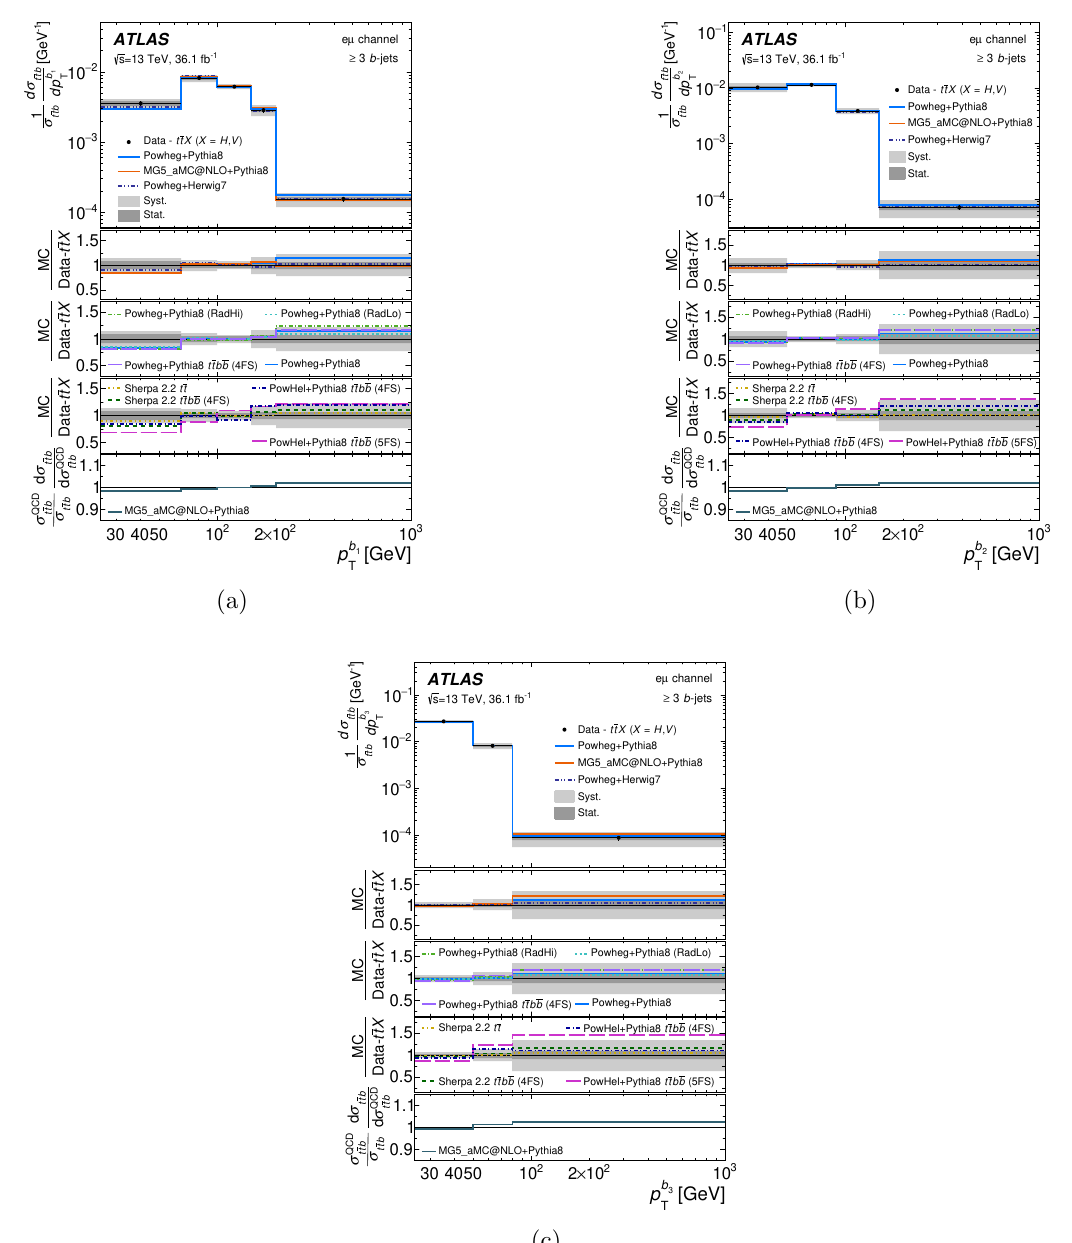
Figure 12. Relative di(cid:11)erential cross-sections as a function of b -jets p T for p T -ordered b -jets in events with at least three b -jets in the e(cid:22) channel compared with various MC generators. The t (cid:22) tH and t (cid:22) tV contributions are subtracted from data. (a) leading b -jet p T , (b) sub-leading b -jet p T , (c) third-leading b -jet p T . Four ratio panels are shown, the (cid:12)rst three of which show the ratios of various predictions to data. The last panel shows the ratio of predictions of normalised di(cid:11)erential cross-sections from MadGraph5 aMC@NLO+ Pythia 8 including (numerator) and not including (denominator) the contributions from t (cid:22) tV and t (cid:22) tH production. Uncertainty bands represent the statistical and total systematic uncertainties as described in section 8. Events with b -jets p T values outside the axis range are not included in the